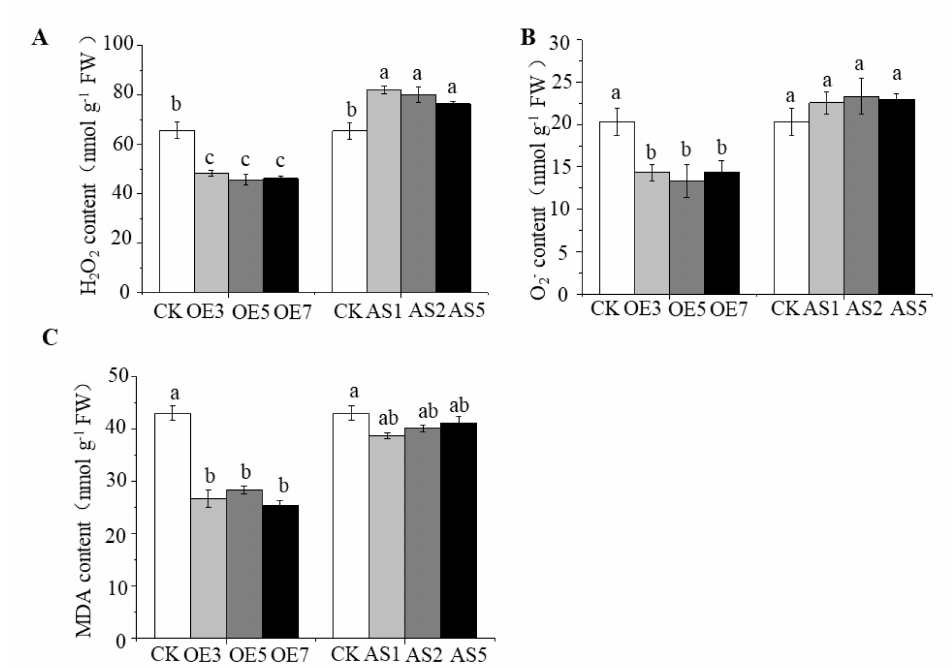
Figure 8. Reactive oxygen species (ROS) and malondialdehyde (MDA) levels in the leaves of control, CsGSH2- overexpressing (OX), and antisense (AS) plants at 48 h after propamocarb application. ( A ) Peroxide (H 2 O 2 ) content. ( B ) Superoxide (O 2 − ) content. ( C ) MDA content. Data are the means of three replicates with SE, and different letters indicate significant differences ( p <